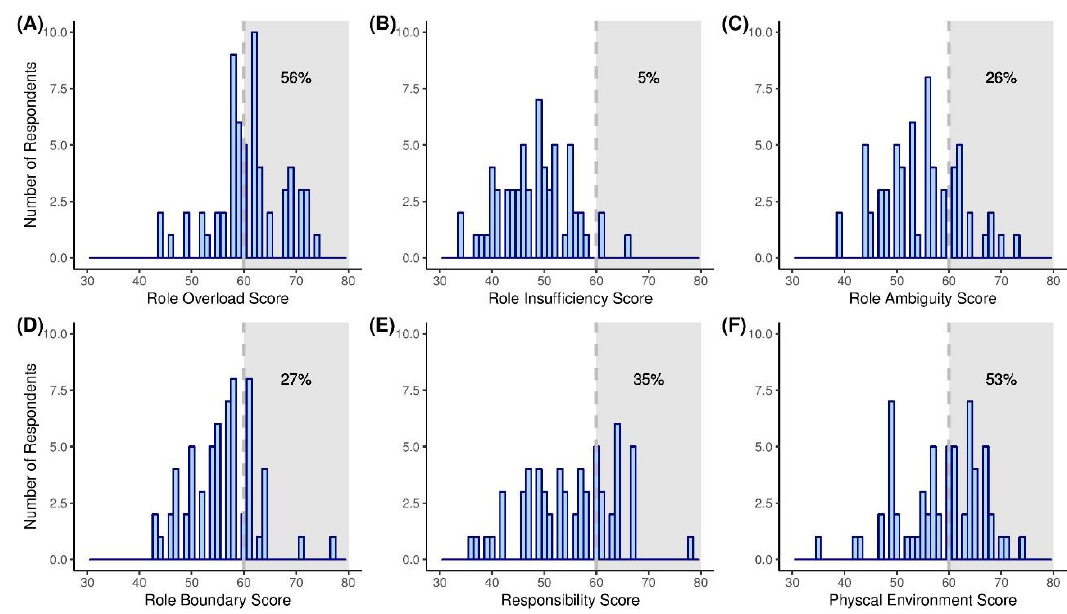
Figure 2. Occupational role scores from the Occupational Stress Inventory—Revised edition. Histograms depicting score frequency by the subdomains of ( A ) Role Overload, ( B ) Role Insufficiency, ( C ) Role Ambiguity, ( D ) Role Boundary, ( E ) Responsibility, and ( F ) Physical Environment. Shaded regions which T scores greater than 60 indicate the presence of a burden of occupational stress in each subdomain.